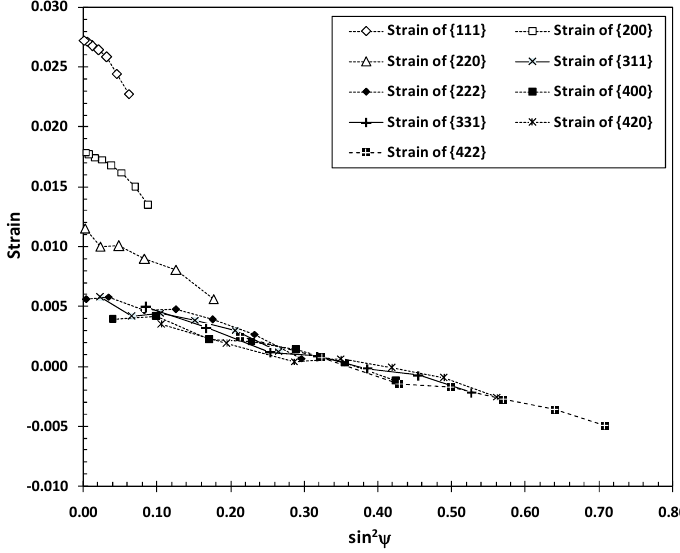
Figure 6. Residual strains estimated as a function of both the employed lattice plane { hkl } and the off-axis angle ψ .